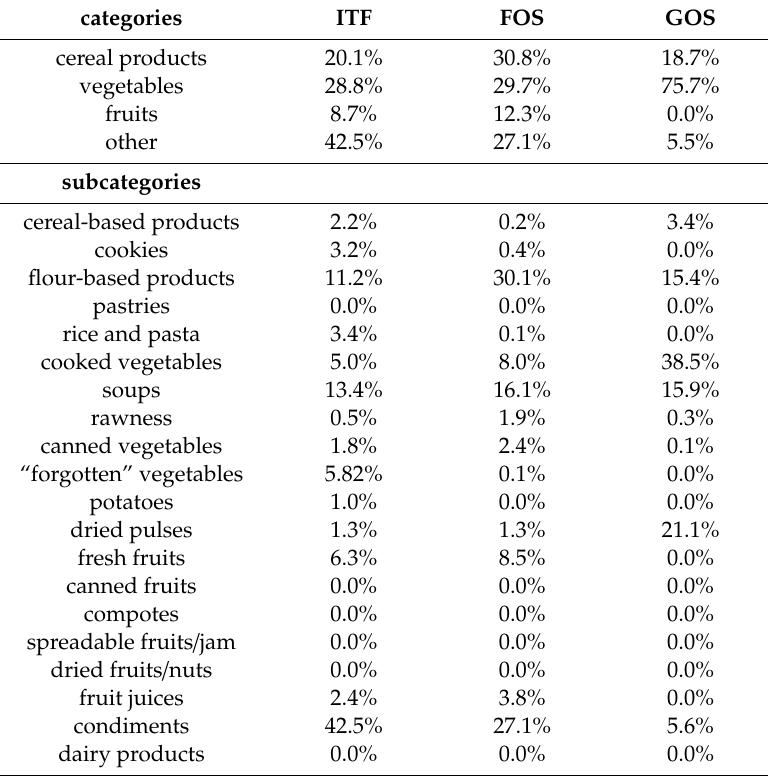
Table 1. Principal food sources for daily prebiotic intake 1